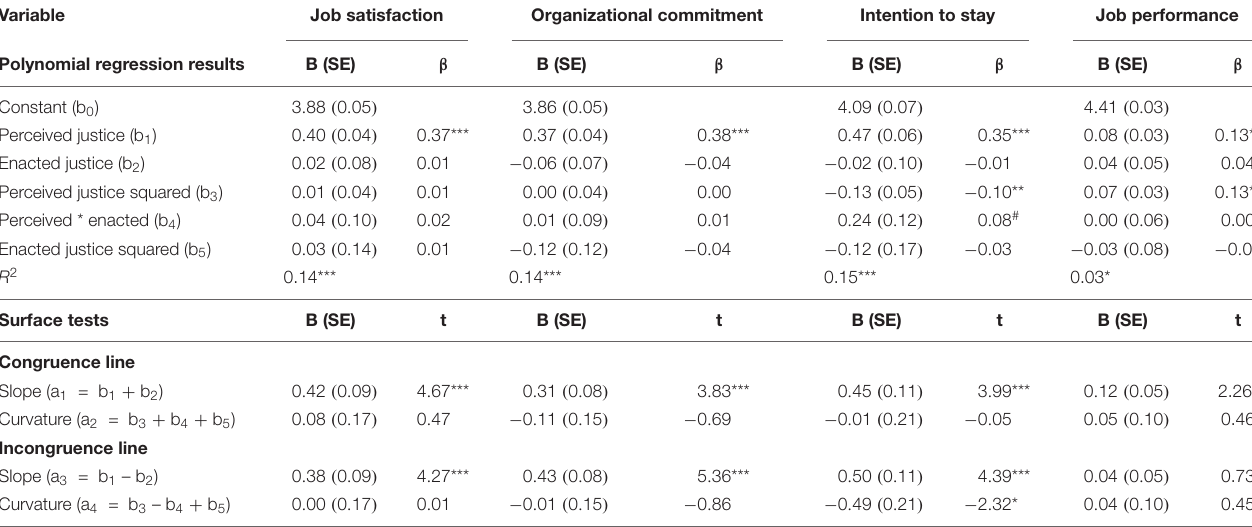
TABLE 2 | Results of the polynomial regression analysis, including response surface analysis, to predict work-related outcomes. Variable Job satisfaction Organizational commitment Intention to stay Job performance